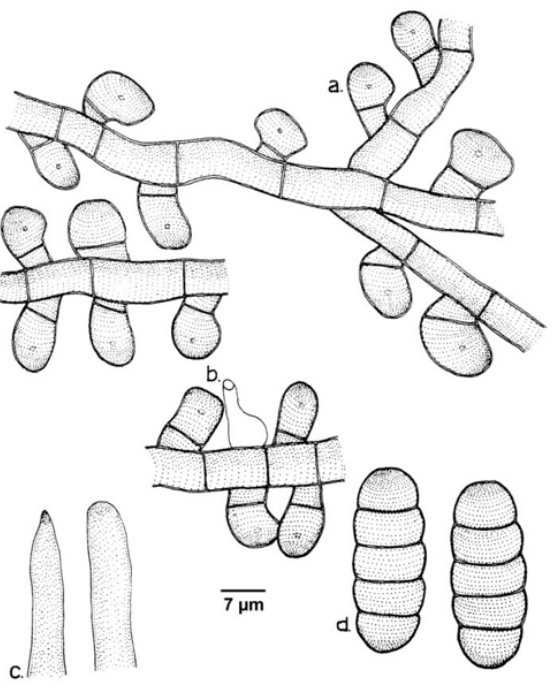
Figure-78. Meliola groteana var. maesae a - Appressorium; b - Phialide; c - Apical portion of mycelial setae; d - Ascospores